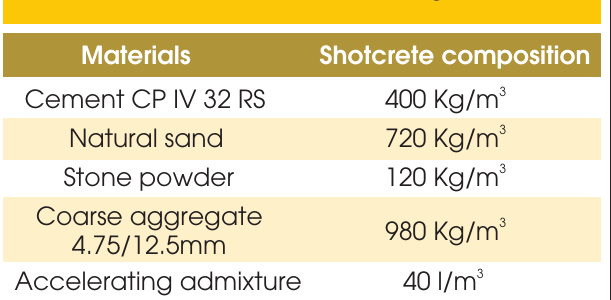
Table 1 – Shotcrete mixture composition used in the tunnel lining